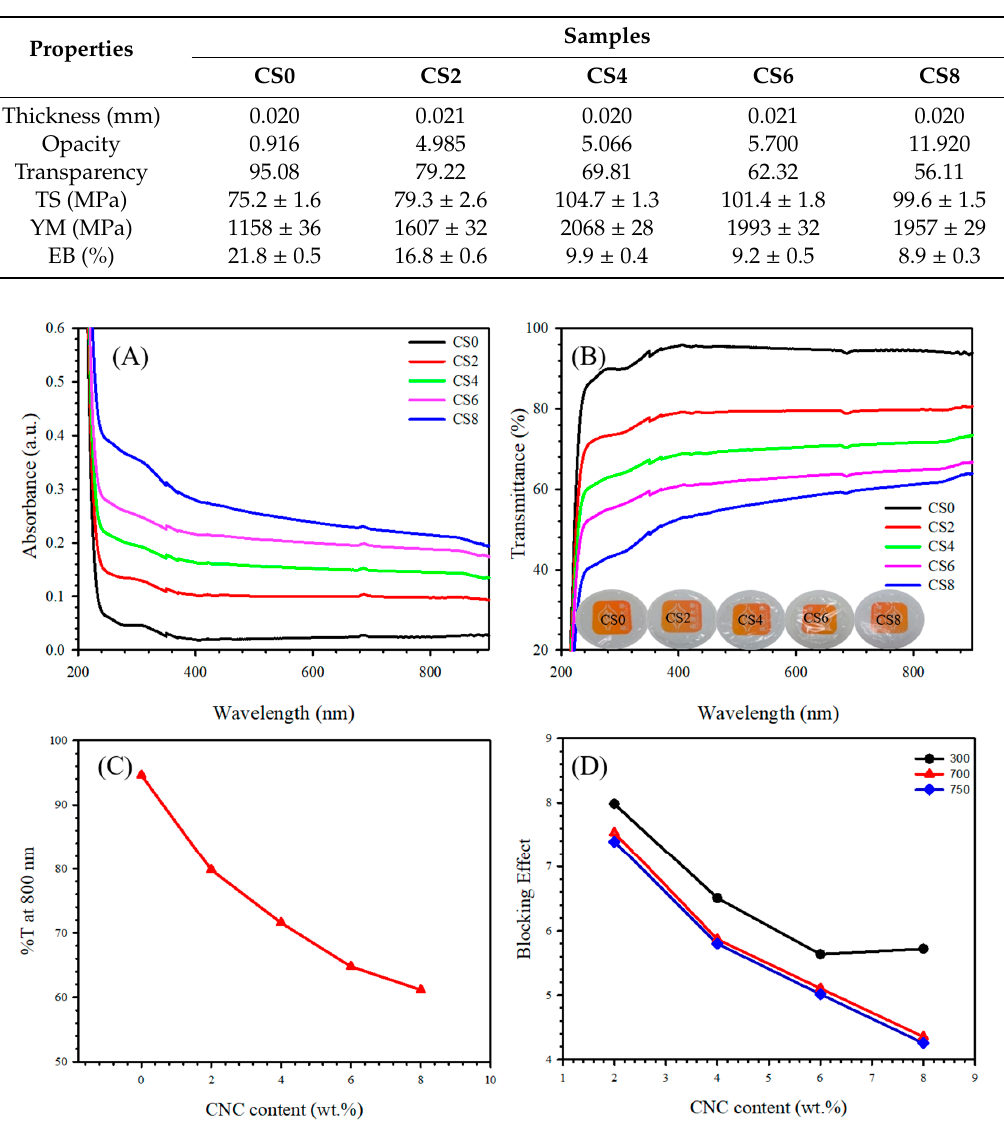
Figure 7. ( A ) UV absorption curve, ( B ) UV transmittance curve, ( C ) optical percentage transmittance (%T) of UV at 800 nm, and ( D ) blocking effect of UV at different wavelengths for CS0, CS2, CS4, CS6, and CS8 films. Inset of Figure ( B ): digital image of fabricated films.